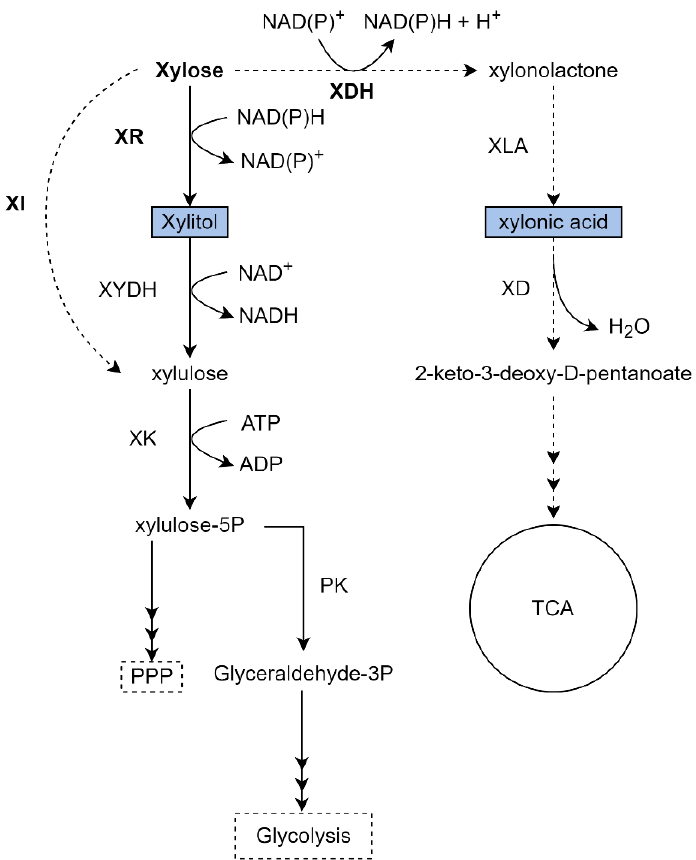
Figure 4. Metabolic pathways to xylose assimilation and production of a variety of chemicals by K. phaffii. Black arrows represent the native xylose metabolism, dotted arrows represent an overexpressed/heterologous pathway. Bold enzyme names represent an overexpressed/heterologous enzyme, and the blue boxes represents the product formation. Some reactions are summarized for better comprehension. XR: Xylose reductase; XI: Xylose isomerase; XYDH: Xylitol dehydrogenase; XK: Xylulo kinase; PK: Phosphoketolase; XDH: Xylose dehydrogenase; XLA: Xylono lactonase; XD: Xylonate dehydratase. The figure of own authorship is based on KEGG pathways (www.genome.jp — accessed on 13 September 2022) and in the literature cited in the text.